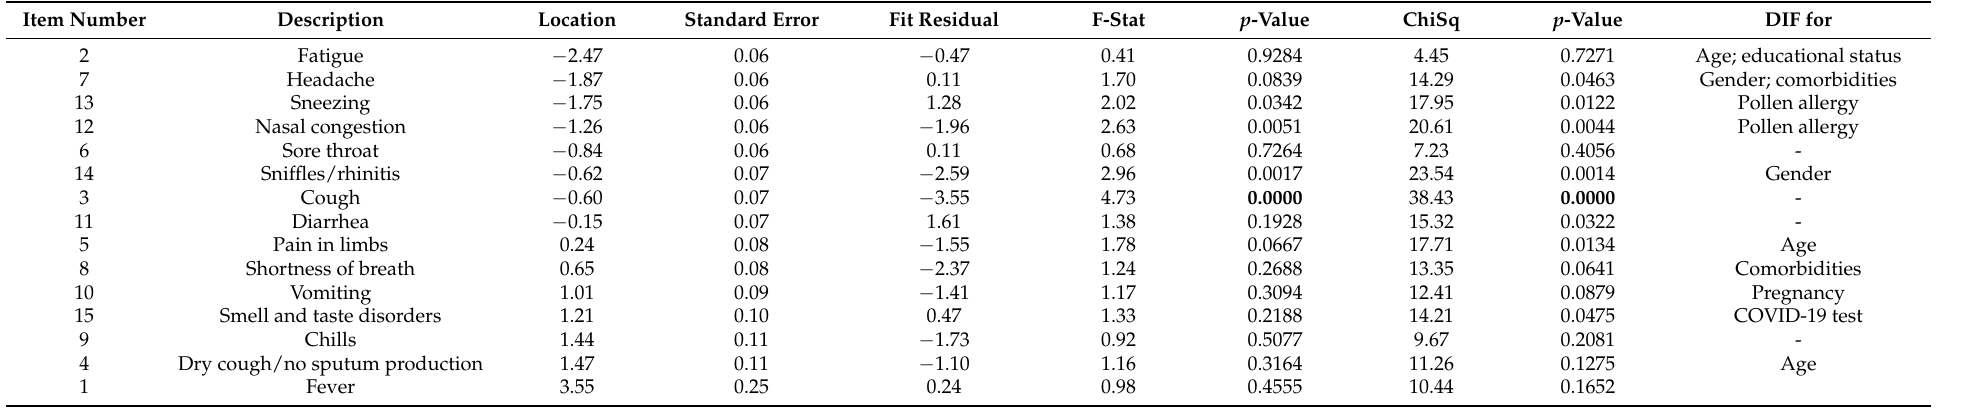
Table 3. Item fit statistics sorted in ascending order according to item location in the data set with the items affirmed, if they were scored positively at least once by each participant during the observation period. The smallest (negative) item location of fatigue implies that it was the item with the highest likelihood to be affirmed, whereas fever showed the lowest likelihood. Only one item (item 3 cough) showed a fit residual below the threshold of − 2.5 and a significant F-test, which represented individual item misfit. Cough also had a significant chi-squared value which can be interpreted as misfit to the latent trait. The Bonferroni corrected significance level was 0.000667. Significances are highlighted in bold letters. Differential item functioning (DIF; depicted in the far right column) exists, if the expected response to a specific item differs between respondents from different sub-groups of persons (e.g., females versus males, people from different age groups or people with and without comorbidities), even though they have the same ‘ability’/likelihood to affirm the same number of